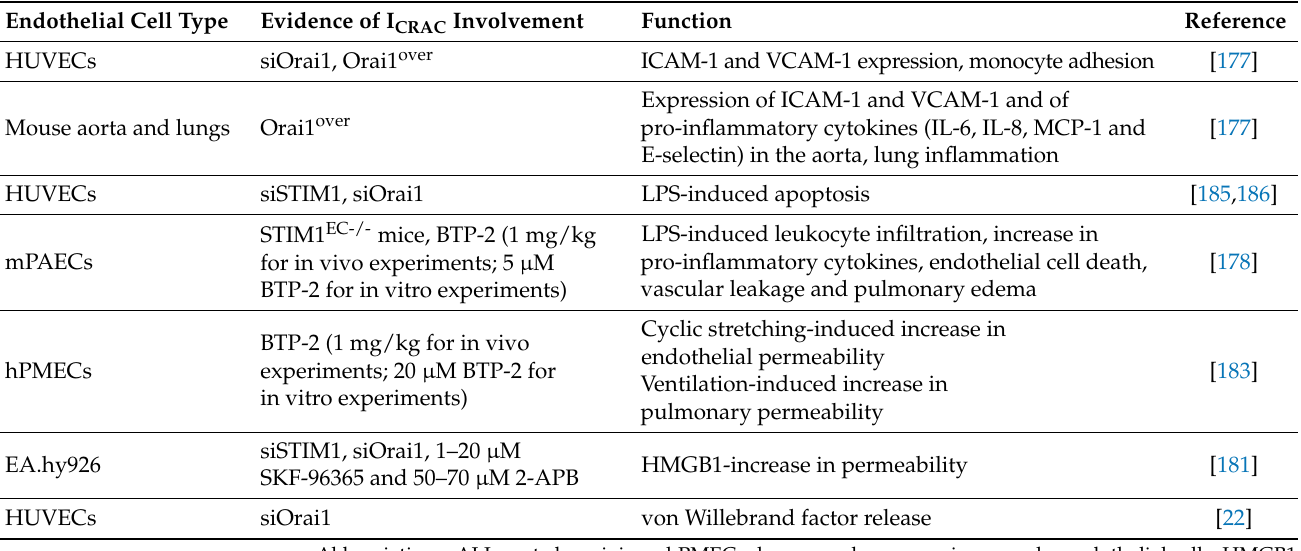
Table 4. Role of the I CRAC in endothelial